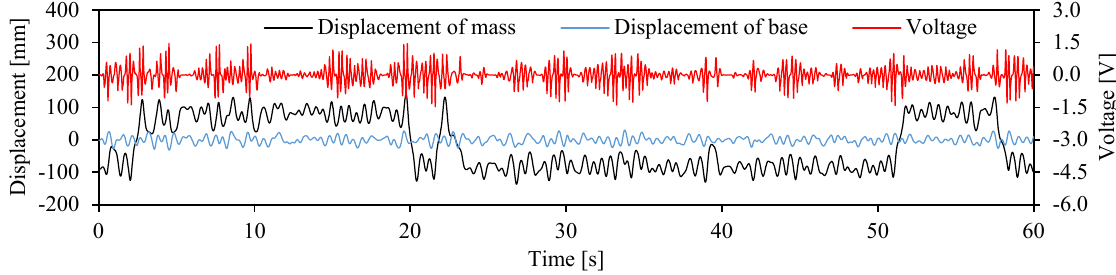
block and support point were 20.70 and 9.84 mm, respectively, which resulted in 2.18 mW of power generated. Figure 20. Results based on co-excitation of random and 1.6 Hz periodic signals.